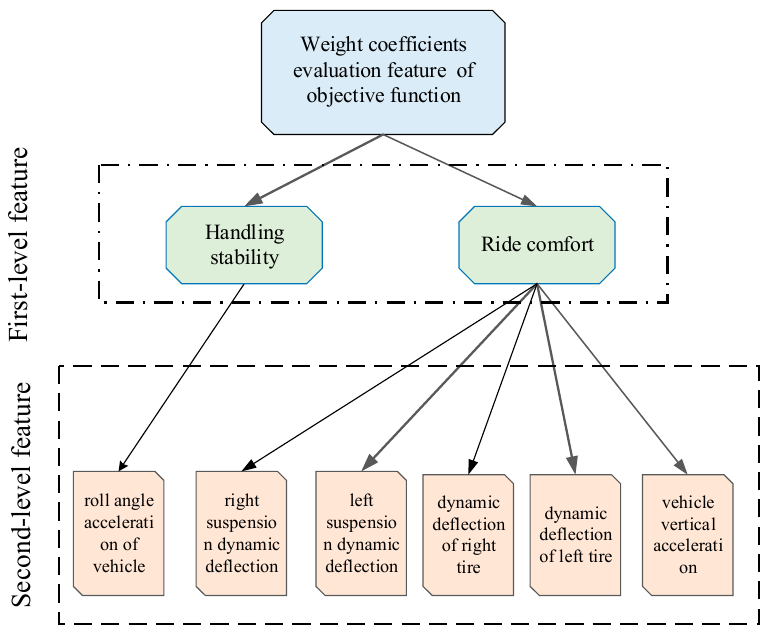
Figure 8. Hierarchical analysis model of AHP.